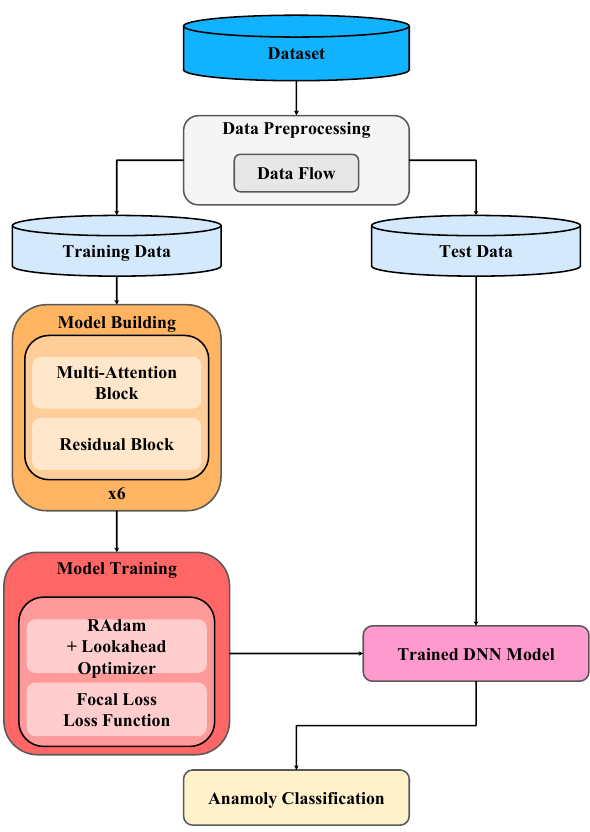
Figure 7. The workflow of the proposed method.